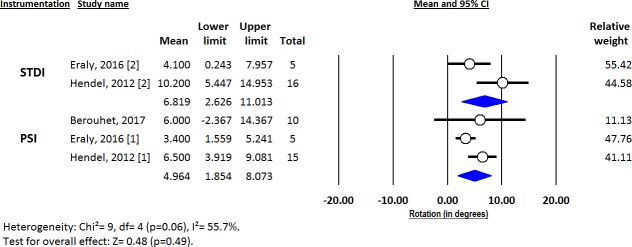
Forest plot of rotation deviation from the pre-operative planning, for all included studies.